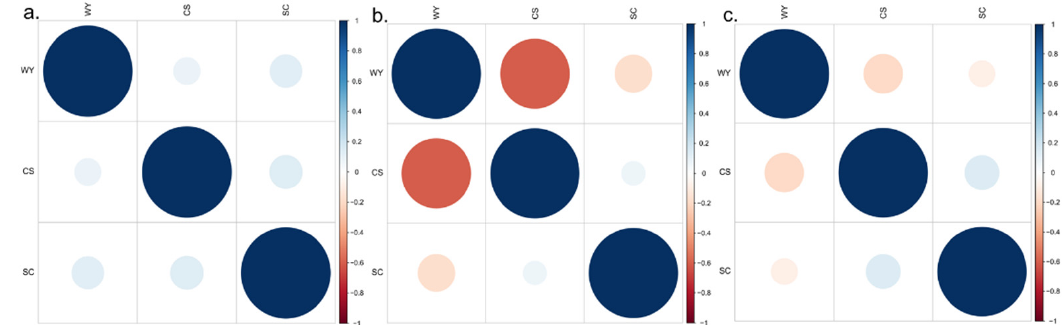
Figure 7. Correlation heat map between the three ecosystem services in different scenarios. CS: carbon storage; SC: soil conservation; WY: water yield. Blue indicates a positive correlation, and red indicates a negative correlation. ( a ) conservation scenario; ( b ) development scenario; ( c ) natural scenario.